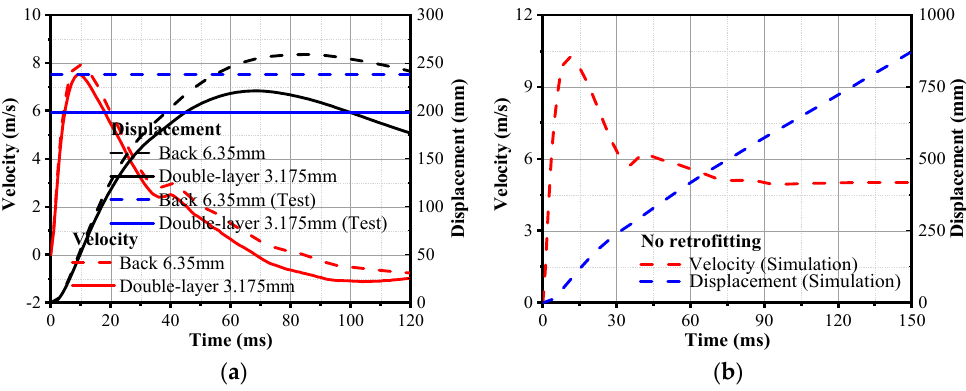
Figure 10. Velocity- and displacement-time histories in Test 2: ( a ) retrofitted; ( b ) no retrofitting.